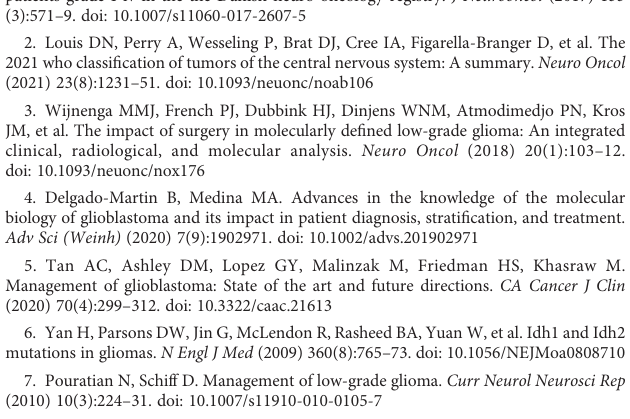
SUPPLEMENTARY FIGURE 1 The pathway enrichment analysis between subtype 2 and subtype 1. (A-E) Enrichment analysis of differentially expressed TPRs using the GSEA (A)/KEGG (B)/GO terms (C-E). SUPPLEMENTARY FIGURE 2 The differential expression of TPRs in LGG samples and normal brain tissues. (A- B) The heatmap and volcano diagram exhibiting the differentially expressed TPRs between LGG tumors and normal tissues. SUPPLEMENTARY FIGURE 3 The pathway enrichment analysis between the two risk groups. (A) The comprehensive function enrichment analysis (GO/KEGG) of differentially expressed TPRs between high-risk and low-risk groups. (B-E) The GSEA analysis of immune-related pathways between low-risk and high-risk groups. SUPPLEMENTARY FIGURE 4 The differential expression of immune-related genes between high-risk and low-risk groups in the TCGA-LGG cohort, including immune stimulators (A) , MHC molecules (B) , immune inhibitors (C) , chemokine receptors (D) , and chemokines (E) . SUPPLEMENTARY FIGURE 5 The relationship between TRP signature and mutation ( ATRX and TP53 ) status. (A-B) The risk score between mutant ( TP53 (A) and ATRX (B)) and wild-type group. (C-D) The subgroup survival analyses of ATRX mutation and TP53 mutation between high-risk and low-risk